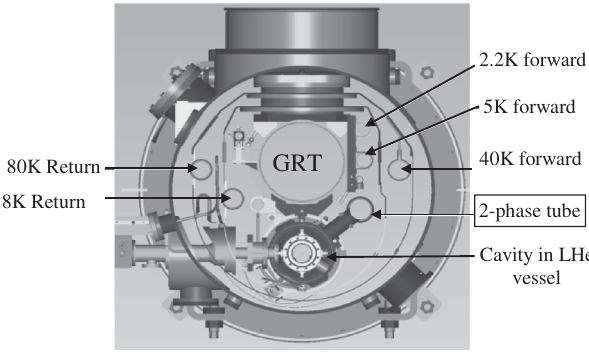
FIG. 2. Cross section of the XFEL cryomodule. GRT stands for gas return tube.